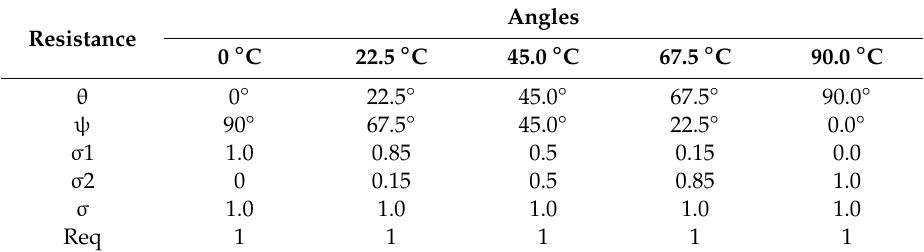
Table 2. Predicted conductivity of CFRP ply using on the simple resistor model. Resistance